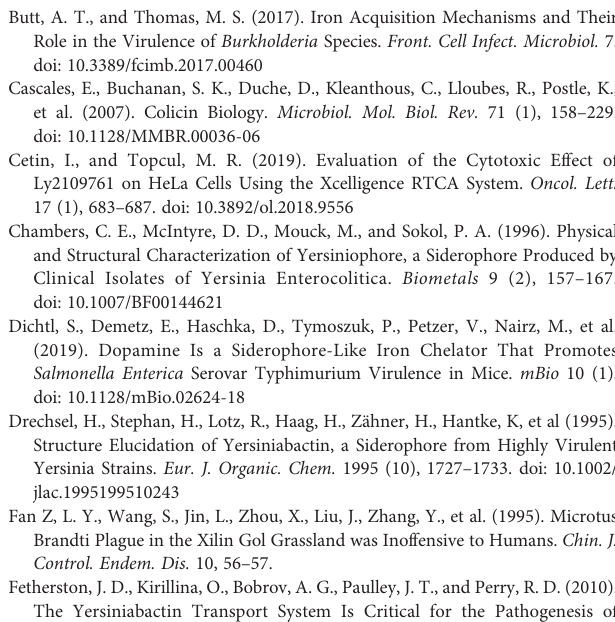
Supplementary Figure 1 | Identi fi cation of the D fyuA and D fyuA GCAdel mutants. (A) PCR analysis of the mutant strain D fyuA . Lanes 1 and 4: Negative control.